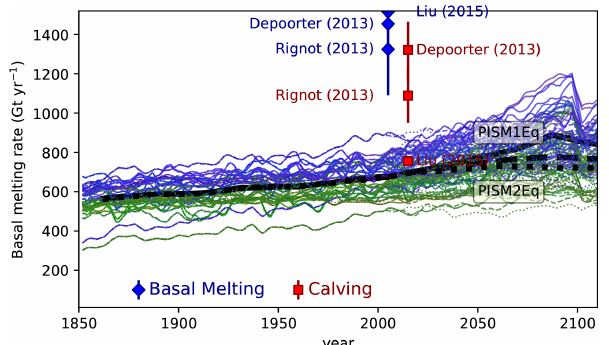
Figure E13. Temporal evolution of the basal melting rates in ice shelves around Antarctica for the period from 1850 to 2100. All simulations start under historical conditions and continue after 2005 under the RCP8.5 (solid lines), RCP4.5 (dashed lines), or RCP2.6 (dotted lines) scenarios. After the year 2100, the forcing of the last 30 years until 2100 drives the model recurrently. The thin blue lines are all ensemble members starting from the PISM1Eq initial state, where the Eigen-calving parameter amounts 10 18 ; the green lines are the corresponding simulations starting from PISM2Eq (Eigen-calving parameter 10 17 ). A running mean with a 5-year window has been applied for the thin lines. The thick black lines represent the ensemble mean of the three future scenarios with a 25-year moving window. The applied running means shift the apparent maximum backward in time so that it occurs visually before the year 2100. Recent estimates of the basal melting (blue diamonds) and the calving (red squares) ice mass loss are given for three studies (legend at the bottom; Liu et al., 2015; Depoorter et al., 2013; Rignot et al., 2013). Related uncertainties are given as vertical lines if the uncertainties are larger than the symbol size.